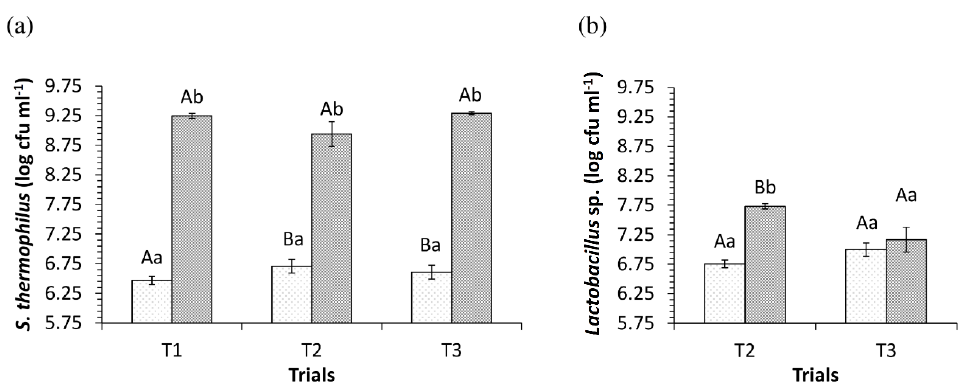
Figure 2. Populations of S. thermophilus in T1 (control), T2 ( L. rhamnosus LR32) and T3 ( L. plantarum CNPC003) trials ( a ) and of Lactobacillus sp . in T2 and T3 trials ( b ) during the fermentation of the dairy bases (light grey dots = initial time; grey square angle = final time). Different uppercase letters denote significant differences between trials for the same fermentation time and microorganism ( p < 0.05). Different lowercase letters denote significant differences between fermentation times for the same trial and microorganism ( p < 0.05).